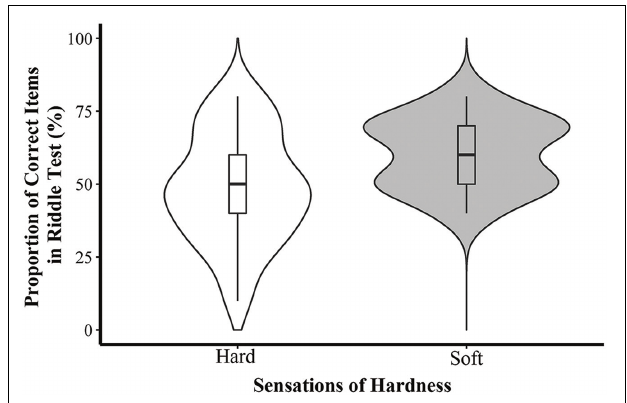
FIGURE 2 | Proportion of correct answers in Chinese riddle task in Experiment 2.